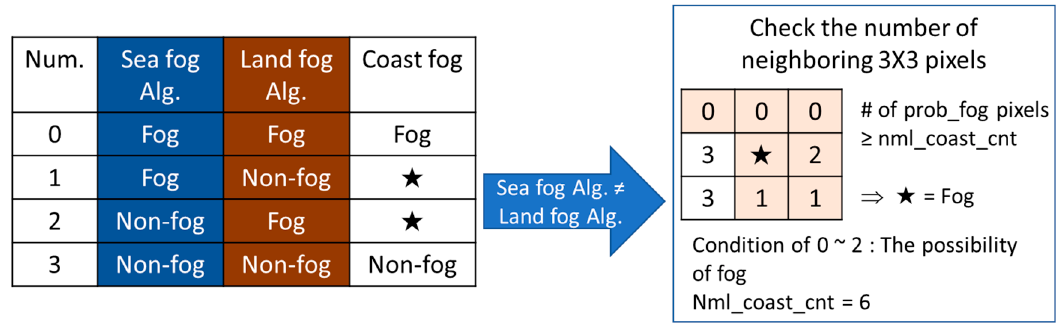
Figure 4. Conceptual diagram for the spatial blending method. The part marked with a star indicates a case where the results of the sea fog algorithm and the land fog algorithm are different from each other.